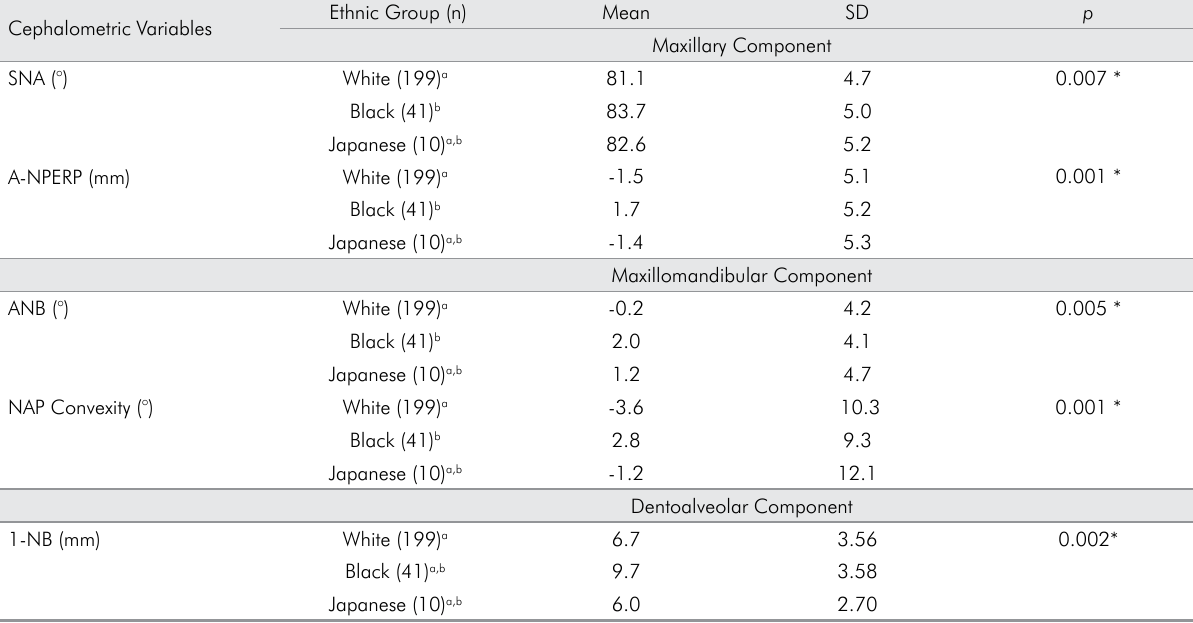
Table 5. Comparison between the ethnic groups and the variables of maxillary component maxillomandibular relationship, and dentoalveolar component: Mean, Standard Deviation (SD), ANOVA ( p ).